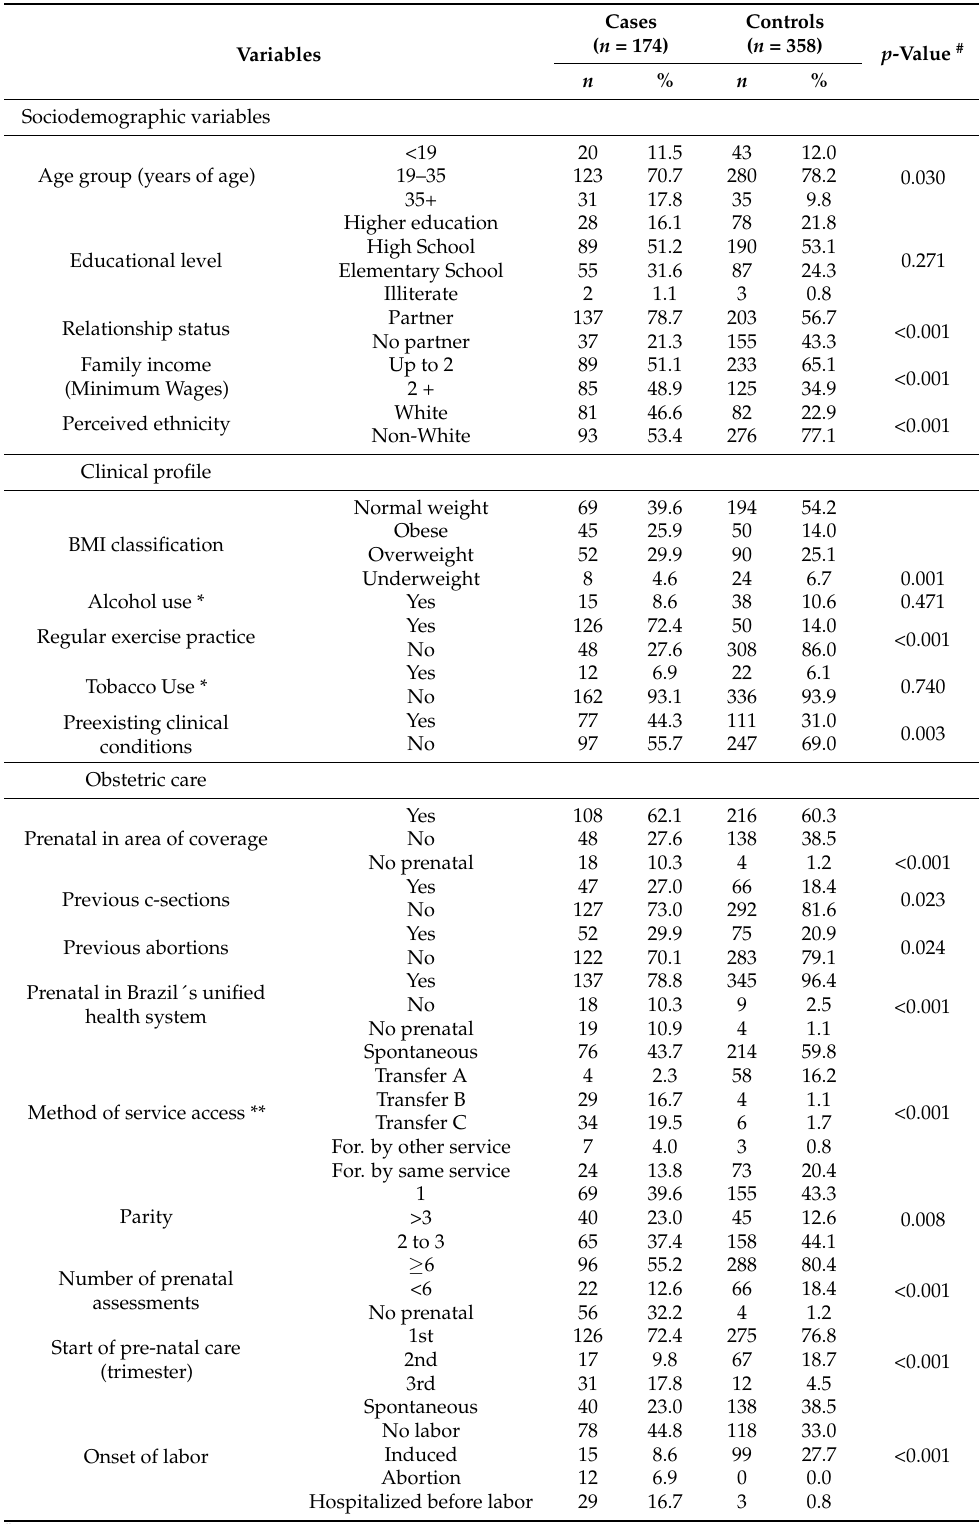
Table 2. Distribution in the number and percentage of women according to socioeconomic, clinical profile and obstetric antecedents’ variables stratified by cases and controls. Brasilia, Federal District,